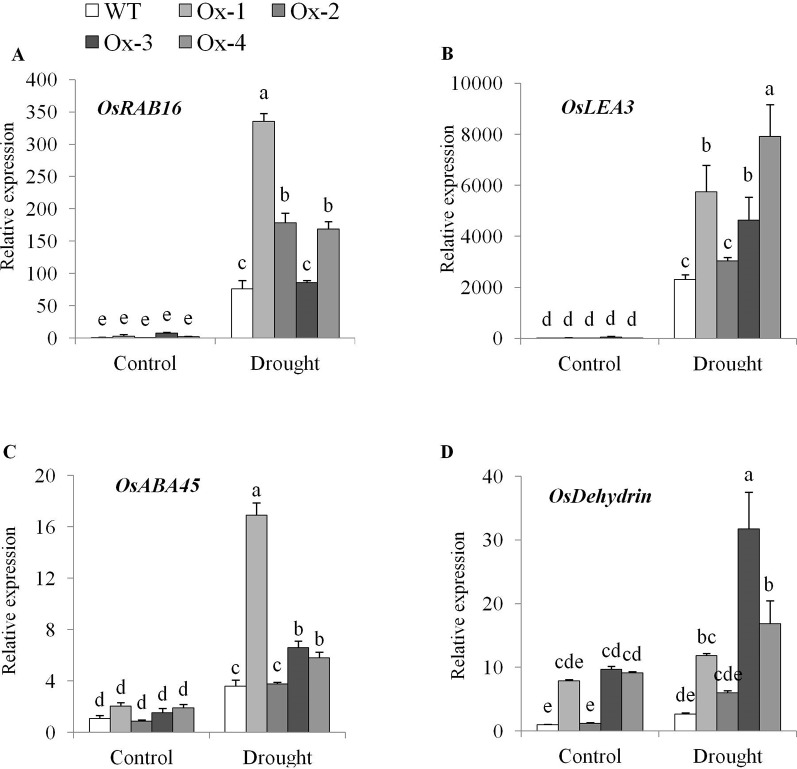
Expression analysis of ABA-dependent pathway genes in OsPYL10 overexpressing transgenic rice and WT plants under control and drought at anthesis. Relative Expression of (A)
OsRAB16, (B)
OsLEA3, (C)
OsABA45 and (D)
OsDEHYDRIN genes. Total RNA isolated from leaf tissues of plants under control and drought (∼ -80 kPa) were used for expression analysis by qRT-PCR. Values are mean from three biological replicates (n = 3). Error bar indicates ± SE. Statistical differences are shown on the bars by labelling significantly different groups with different letters.